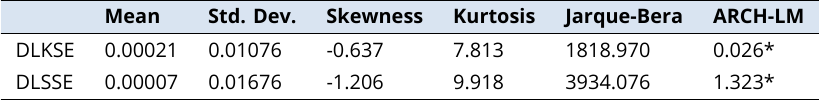
Descriptive statistics of stock market returns